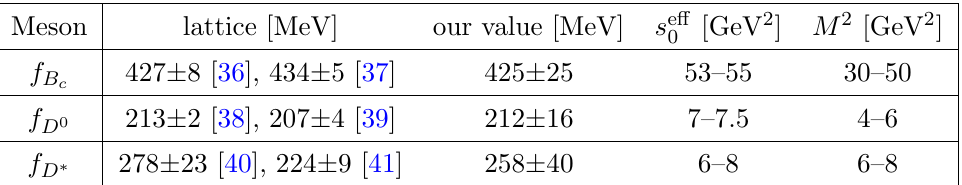
Table 1 . Decay constants of mesons with 3ptSR